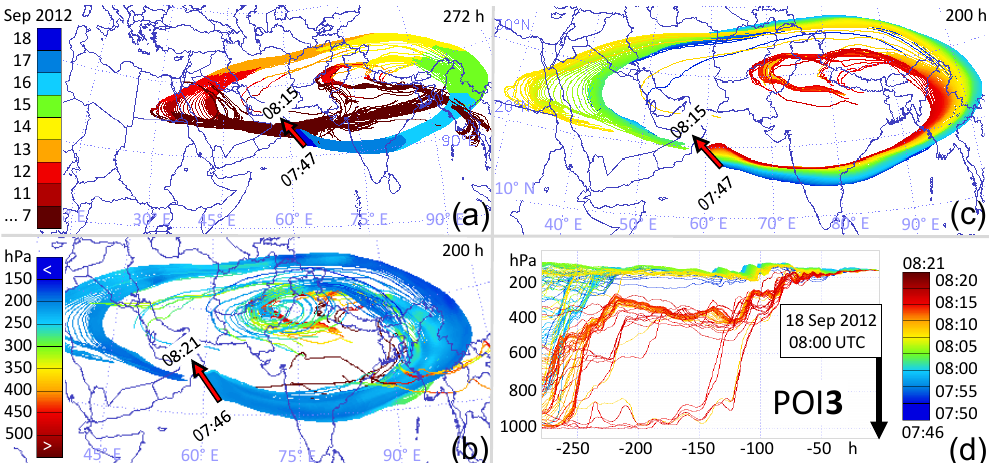
Figure 4. HYSPLIT-simulated backward trajectories starting at the HALO flight track (red arrows). The integration length is noted in the upper-right corner of each lat–lon panel. All trajectories of one panel start at the same time, approximately in the middle of the period corresponding to the respective flight segments (d) . Colours in panel a relate the previous positions of the measured air parcels to calendar days. Colours in (b) show pressure altitude, which is supplemented by altitude vs. time in (d) . Individual trajectories are colour coded according to the time of measurement at their respective starting positions in (c) and (d) . Panels a show the same map section here and throughout Appendix A, while all other panels are scaled